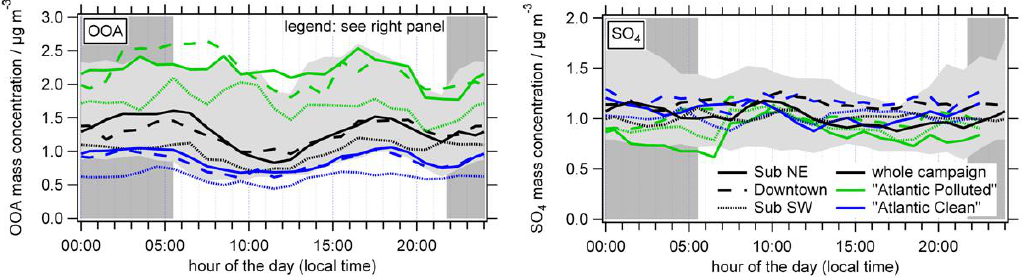
Fig. 6. Diurnal cycles (hourly median values) for OOA (left) and SO 4 (right) at all sites for the whole campaign, and for “Atlantic Polluted” and “Atlantic Clean” air masses separately. The time period between sunset and sunrise is shaded in grey. Percentiles (25 and 75%) are shown in light grey exemplarily for the measurements at Sub NE only (whole